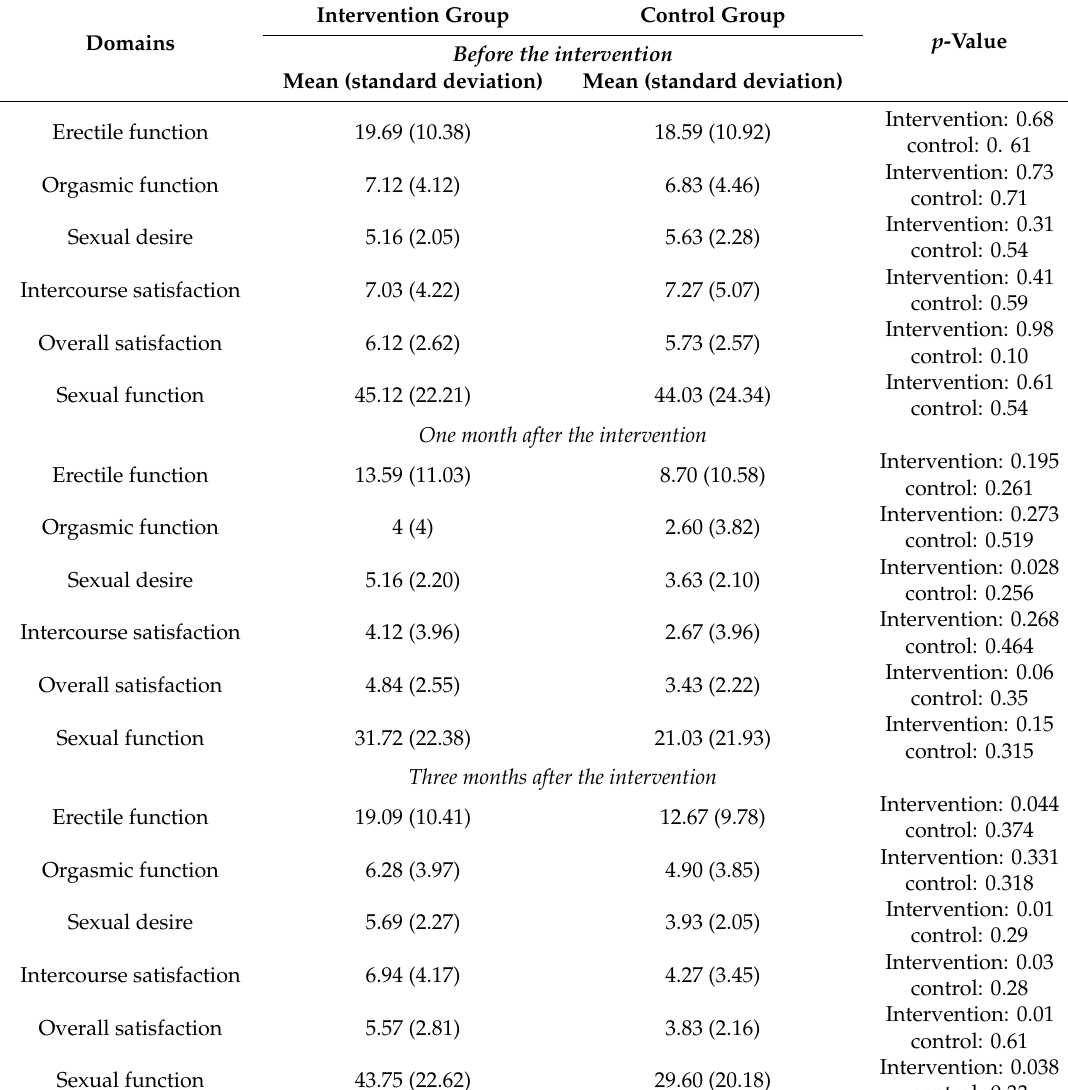
Table 3. Comparison of sexual function before and after the intervention between the